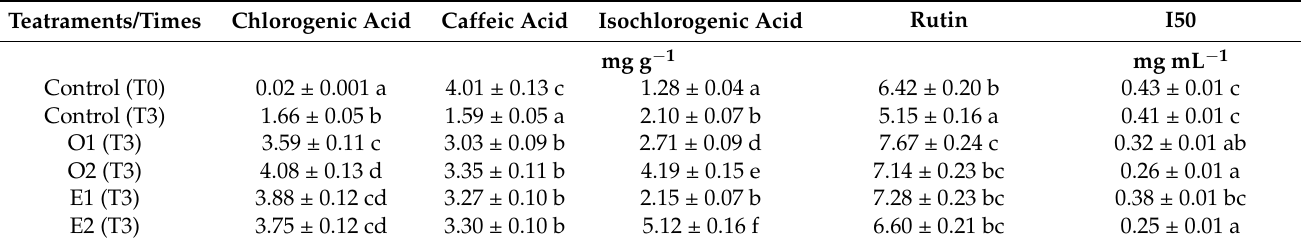
Table 3. Phenolic content and antiradical activity in the extract of plants from different